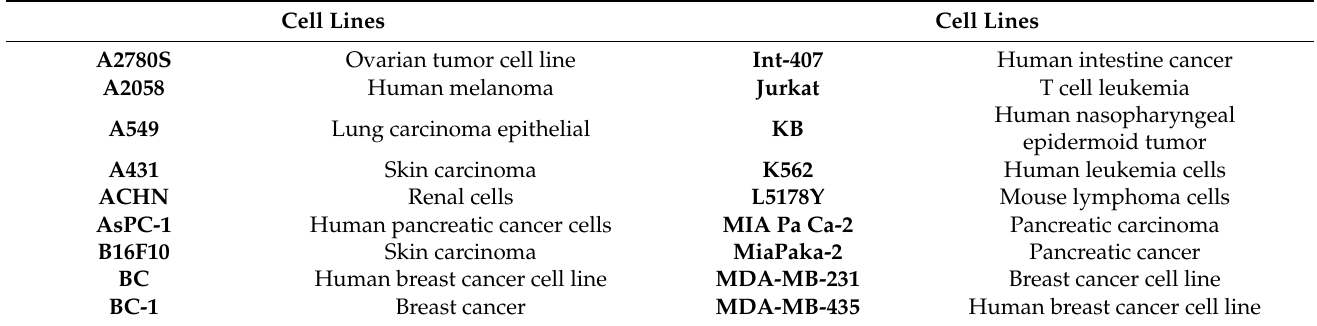
Table 1. Different cell lines against which endophytic fungal derived metabolites showed cytotoxicity. Cell